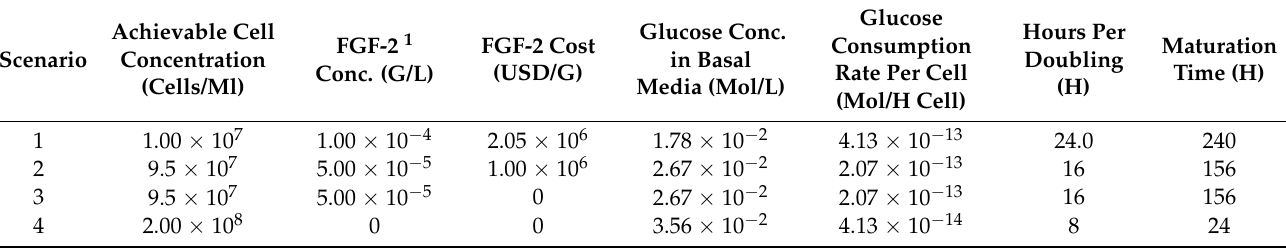
Table 1. Model scenario settings.